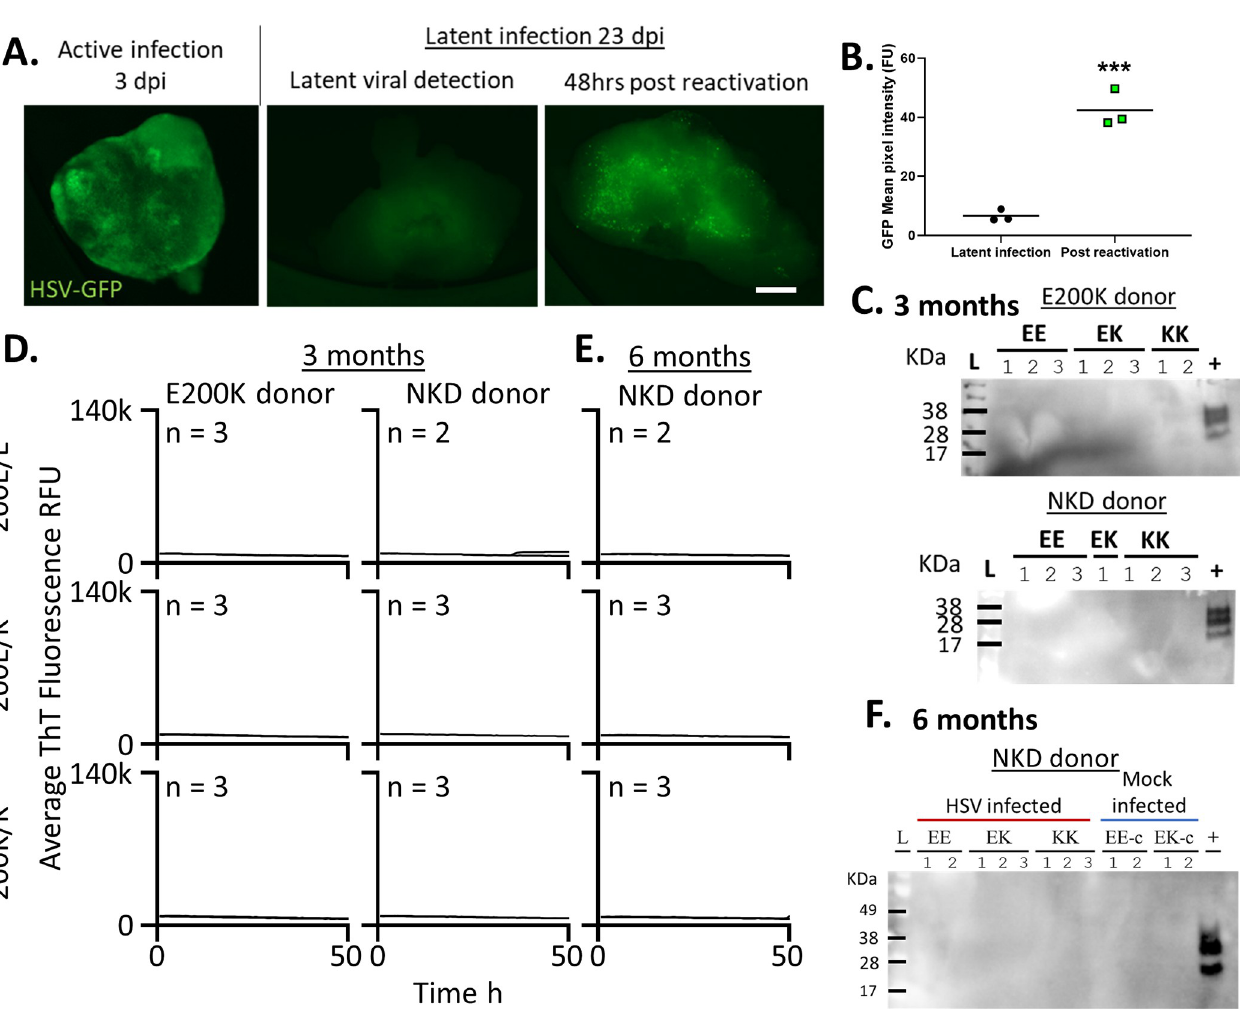
Fig 4. Latent HSV1 infection does not result in emergence of PrP misfolding in the E200K PrP organoids. Organoids were infected with a 0.00001 MOI of McKrae HSV1 while treated with IFN α and brivudine from 24 hr before infection to 14 dpi. A. Example live organoid images of active infection at 3 dpi and latent infection at 23 dpi with or without reactivation by heat shock. Scale bar = 500 μ m. B. Quantification of GFP signal following reactivation of HSV1 replication. Individual points show single organoids (n = 3) and horizontal lines show the average intensity. ��� p < 0.001, Student’s t-test. C. Protease resistant PrP detection in organoids at three months of latent infection compared with sCJD positive control brain homogenate. D. RT-QuIC seeding activity assays at 3 months post infection and E. at 6 months post-infection for the NKD donor. Traces shown are averages of 4 replicate reactions per ‘n’ individual organoids, with the ‘n’ indicated on each graph. None of the samples exceeded the 25% positive well threshold to be considered positive. F. Protease resistant PrP at 6 months of latent infection for the NKD donor compared with positive control sCJD homogenate (+). Numbers above lanes indicates individual organoids. Control organoids (age-matched, treated with compounds and ‘mock’ Vero cell lysates) can be found in S7